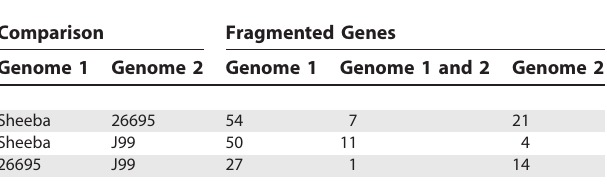
Table 2. Numbers of Fragmented Genes among 1,306